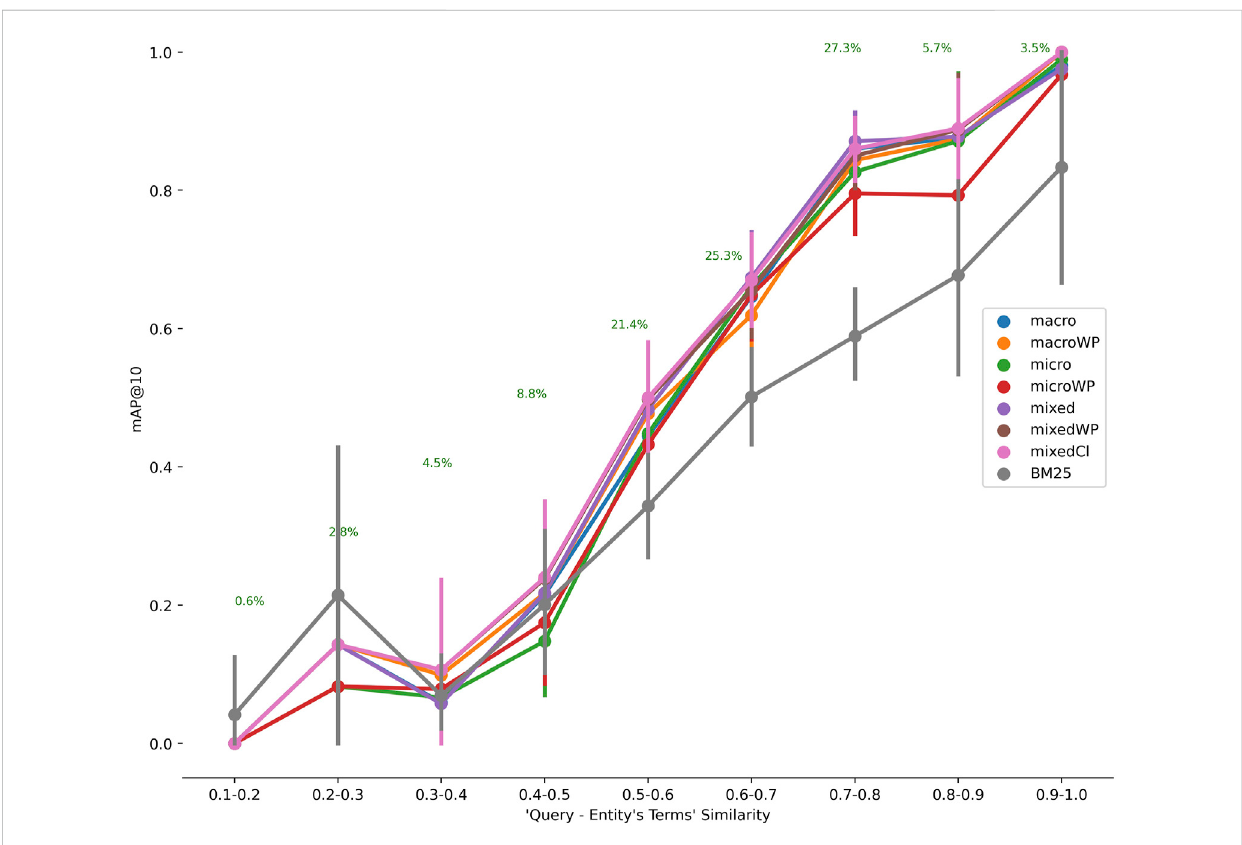
FIGURE 6 Therelationshipbetweenthesimilarityoftermsinthequerywiththoseintheentityto mAP@ 10forPMR-CA.Thenumberofentitiesis4,652andthe number of test data is 509. Generally CASBERT is better than BM25 when the similarity value is 0.3 and above.